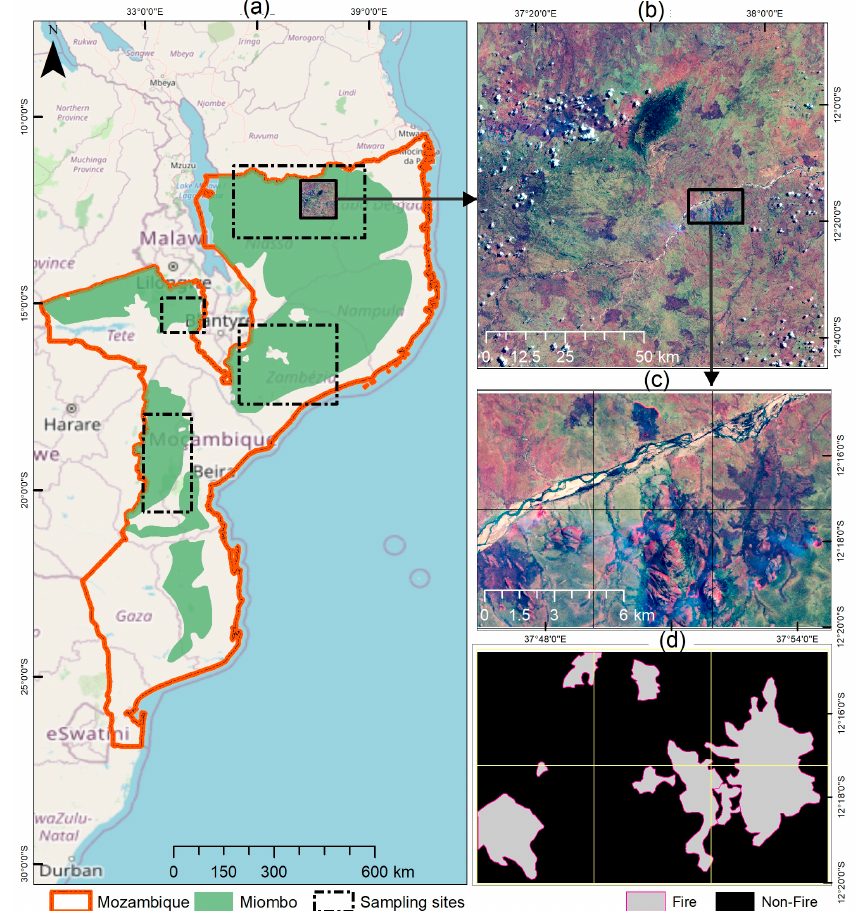
Figure 1. Selected areas in Mozambique: ( a ) the location of the miombo ecoregion (green) and sampling sites for woodland fires (boxes); ( b ) an example of a Sentinel-2 image including the object fires for 13 September 2017; some examples of ( c ) 256 × 256 image patches and ( d ) their corresponding fire labels for training deep learning